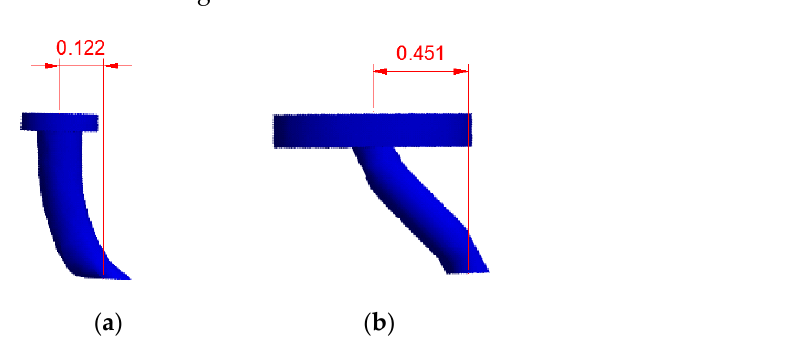
Figure 15. Displacement difference between the top and bottom of the studs at Section 2-2 (mm). ( a ) CSB-1. ( b ) CSB-2.